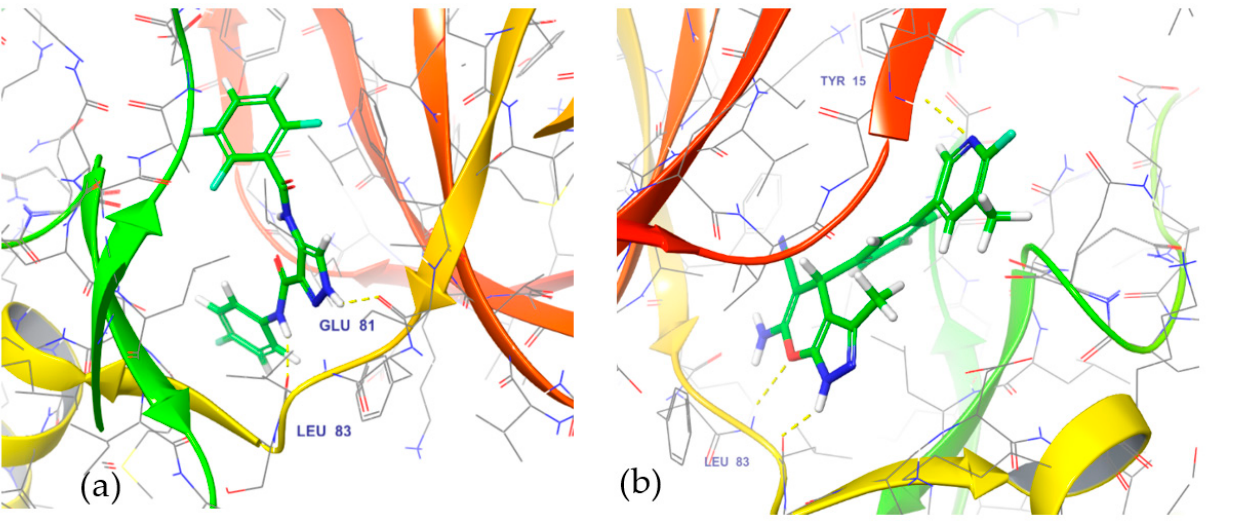
Figure 7. 3D interaction diagram of ligand ( a ) and 5b ( b ) with the amino acid residues of CDK1.